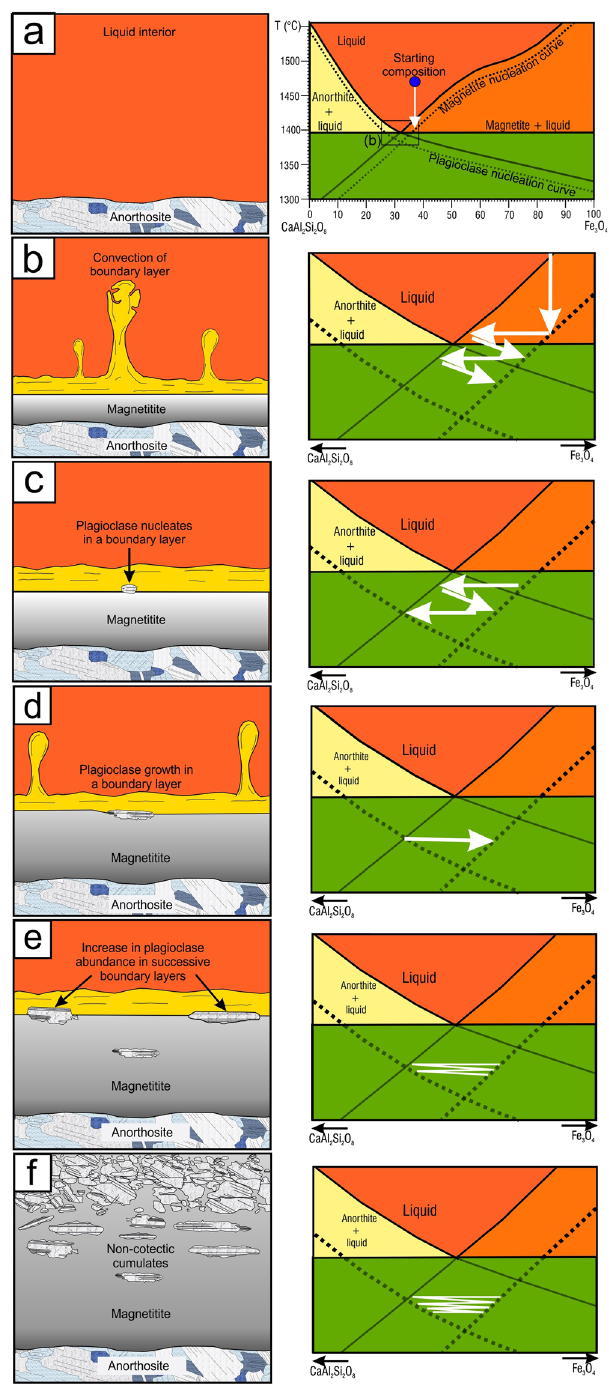
Fig. 7 Cartoons illustrating the process leading to the formation of non- cotectic cumulates by in situ crystallization with corresponding phase diagrams (modi fi ed from Roeder and Osborn 74 ), showing the evolution of the melt directly at the crystal – liquid interface. The green area on the phase diagram represents the subsolidus. Since the phase relations from Roeder and Osborn are based on atmospheric conditions, they are not directly applicable the Bushveld Complex that crystallized at greater